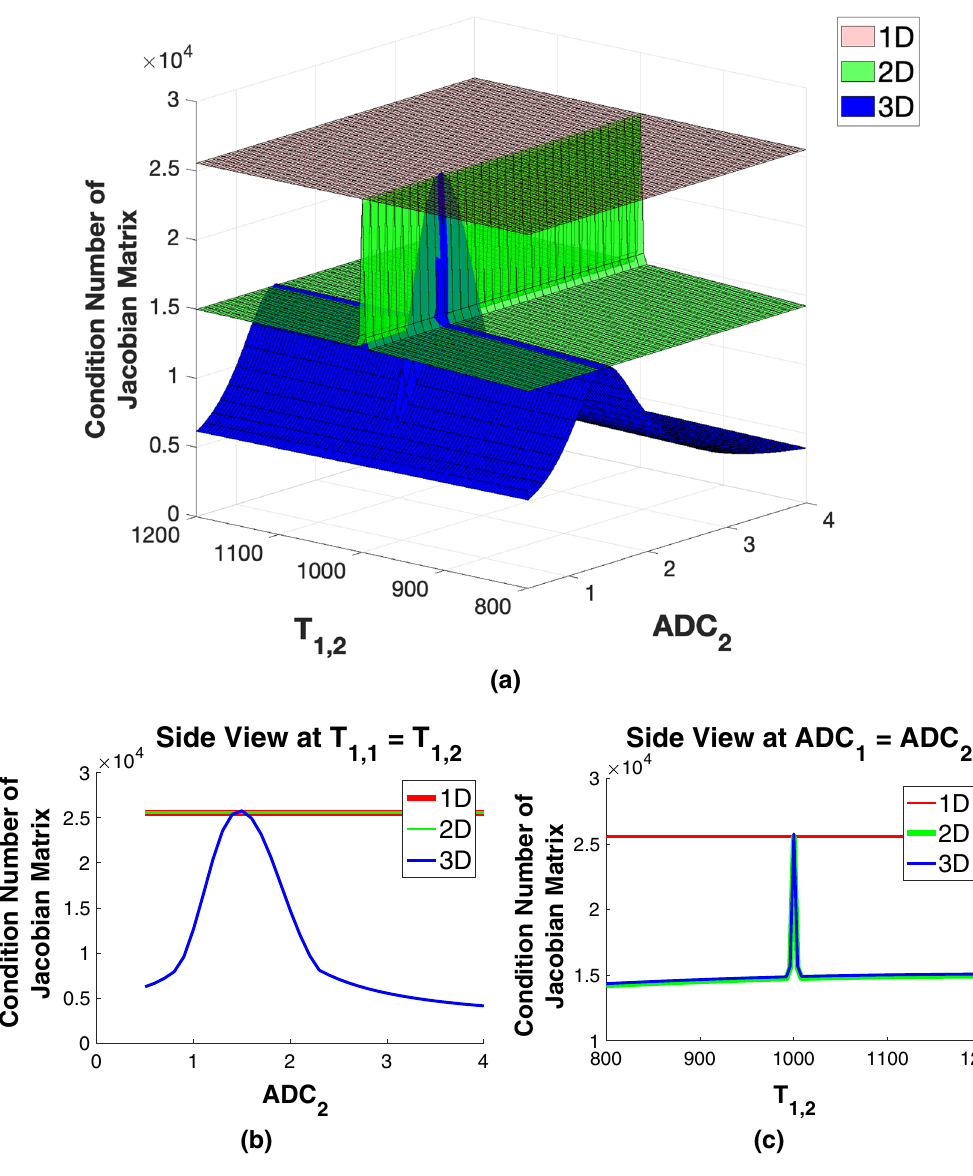
Figure 10. Top: Condition numbers for the Jacobian matrix for 1D, 2D, and 3D models evaluated over a range of T 1,2 and ADC 2 values. Bottom left: Perspective view of the slice through ADC 1 T T 1,1 1,2 . Bottom right: Perspective view of the slice through =